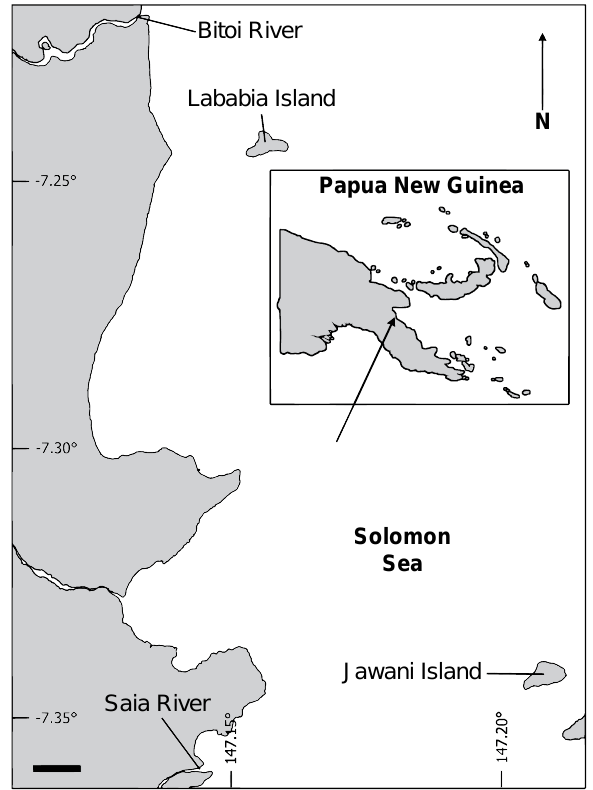
Fig. 1. Map of the sampling area; Kamiali Wildlife Management Area, Papua New Guinea, is bounded by the Bitoi and Saia Rivers and includes Lababia and Jawani Islands; Scale bar = 1 Village residents, through regular fi shing activities